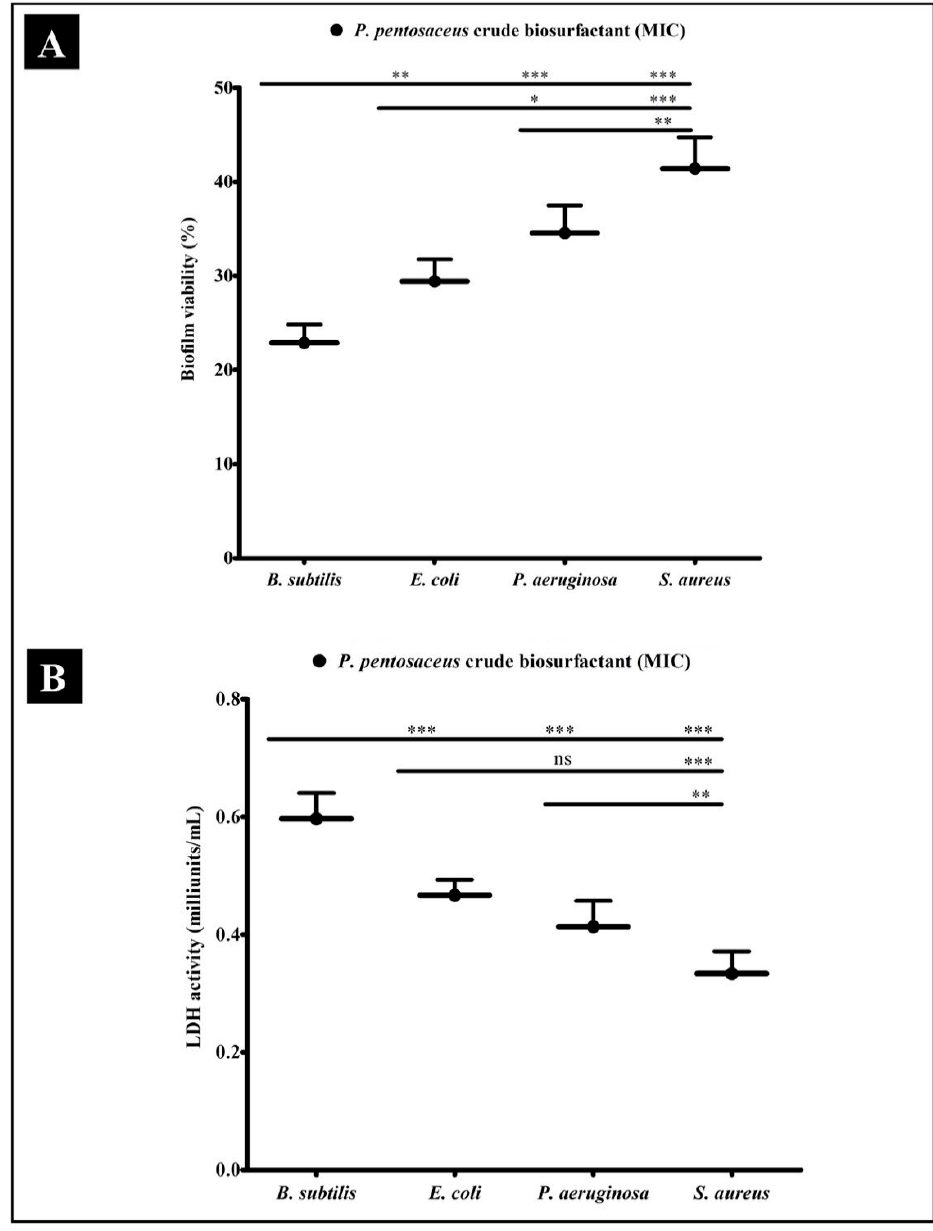
Figure 5. Results of the XTT and LDH assays for confirming the antibiofilm potential of biosurfactant. ( A ) Percentage of bacterial viability within biofilms determined by XTT assay at respective MICs. ( B ) Bacterial cell damage within the biofilm, based on LDH activity upon the treatment of P. pentosaceus crude biosurfactant at respective MICs. Values are represented as mean ± SD of three independent experiments. Significance; ns > 0.05, * p < 0.05, ** p < 0.005, *** p < 0.0005.